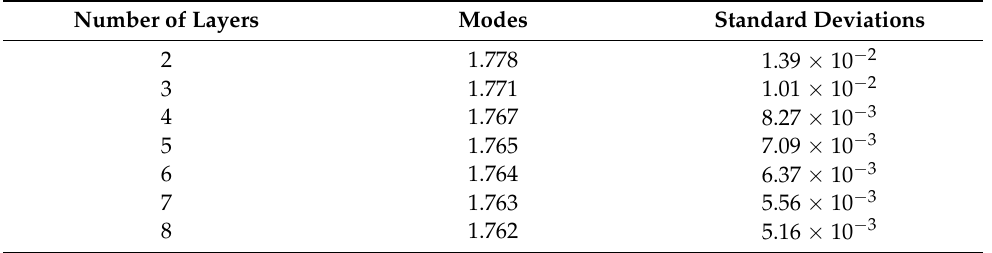
Table 2. Modes and standard deviations for the saturation density of 0.30 and the given number of layers.